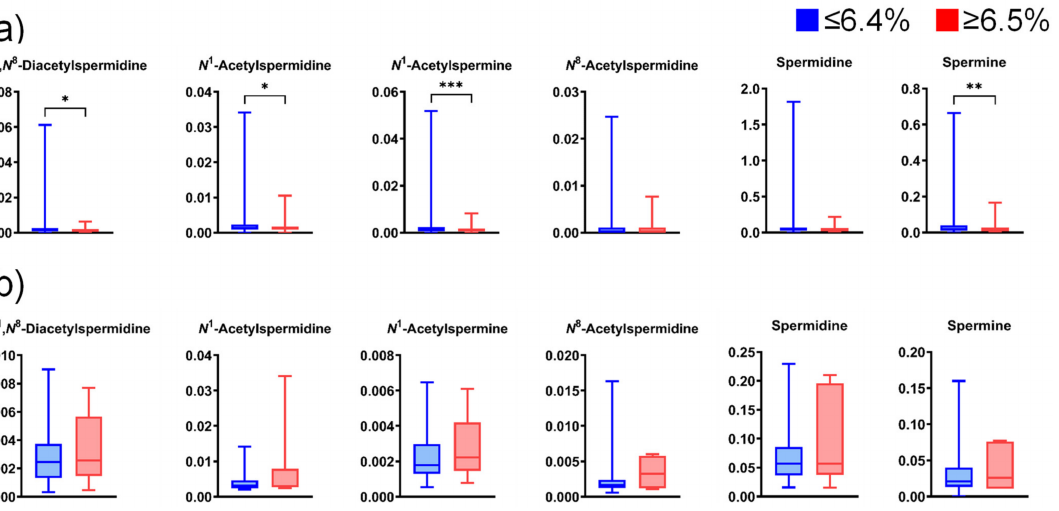
Figure A6. Differences in salivary polyamine concentrations between participants with high and low HbA1c levels. ( a ) Data for healthy individuals (low, n = 789; high, n = 135) and ( b ) patients with pancreatic diseases (low, n = 60; high, n = 7). Horizontal lines of box plots present 0, 25, 50, 75, and 100% of data. * p < 0.05, ** p < 0.01, and *** p < 0.001 using the Mann–Whitney U